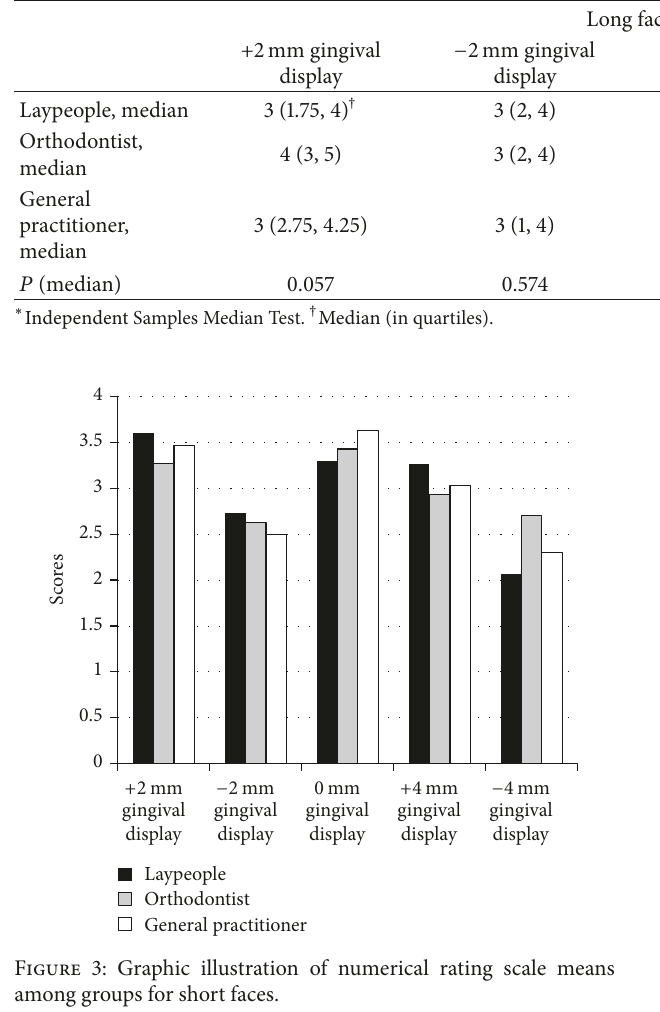
Table 3: Comparison of median scores given by laypeople, orthodontists, and general practitioner dentists for short faces.